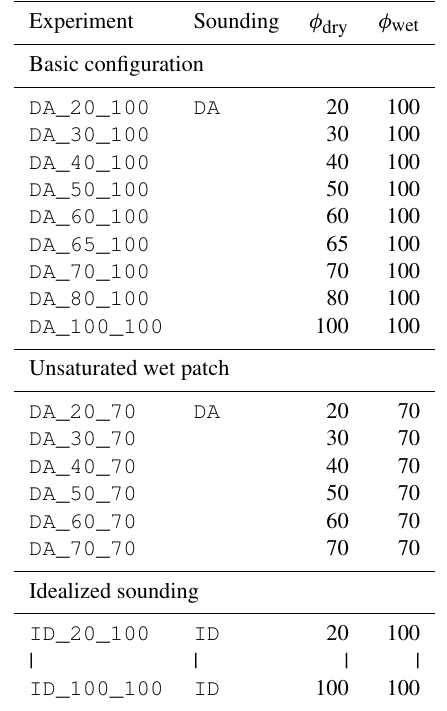
Table 1. Overview of the performed simulations. The first column indicates the experiment name, whereas the second column indi- cates the sounding used for initialization: DA for dry soil advantage, after Findell and Eltahir (2003), and ID for idealized, after Schlem- mer et al. (2012). Third and fourth columns indicate the value of soil moisture over the dry and wet patches, respectively, in percentage of the saturation value. The naming convention for the experiments follows SOUNDING _ φ dry _ φ wet . The vertical lines that characterize the ID cases are used to omit the repetition of the same experiments description, i.e., ID_30_100 , ID_40_100 , etc.